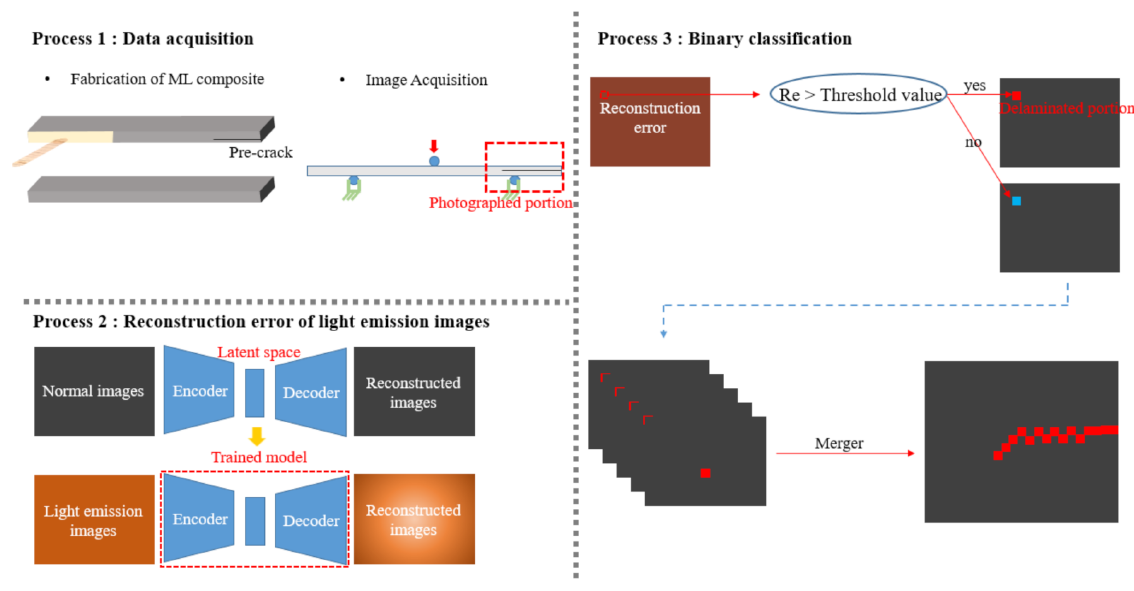
Figure 2. Methodology of the proposed ML image-based delamination